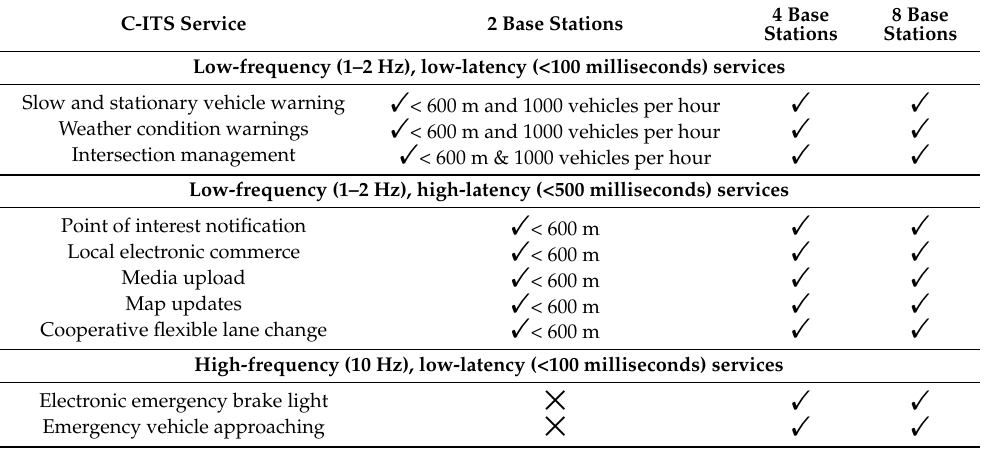
Figure 21. E2E latency simulated for the both modes of the 5G-based C-V2X technology, both infrastructure density deployments and traffic intensity of 1500 vehicles per hour. Table 5. Communication requirements of common C-ITS services and their fulfillment by LTE-based C-V2X in the infrastructural mode and investigated context. Adapted and updated from